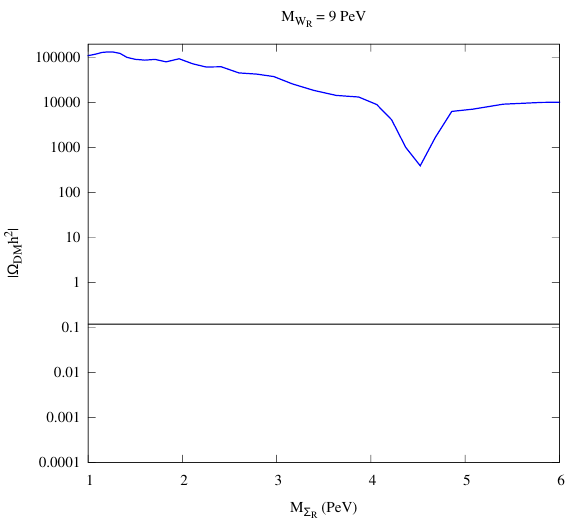
Figure 3 . Relic Abundance of heavy dark matter with only gauge annihilations. The black horizontal band correspond to (cid:10) DM h 2 = 0 : 1187